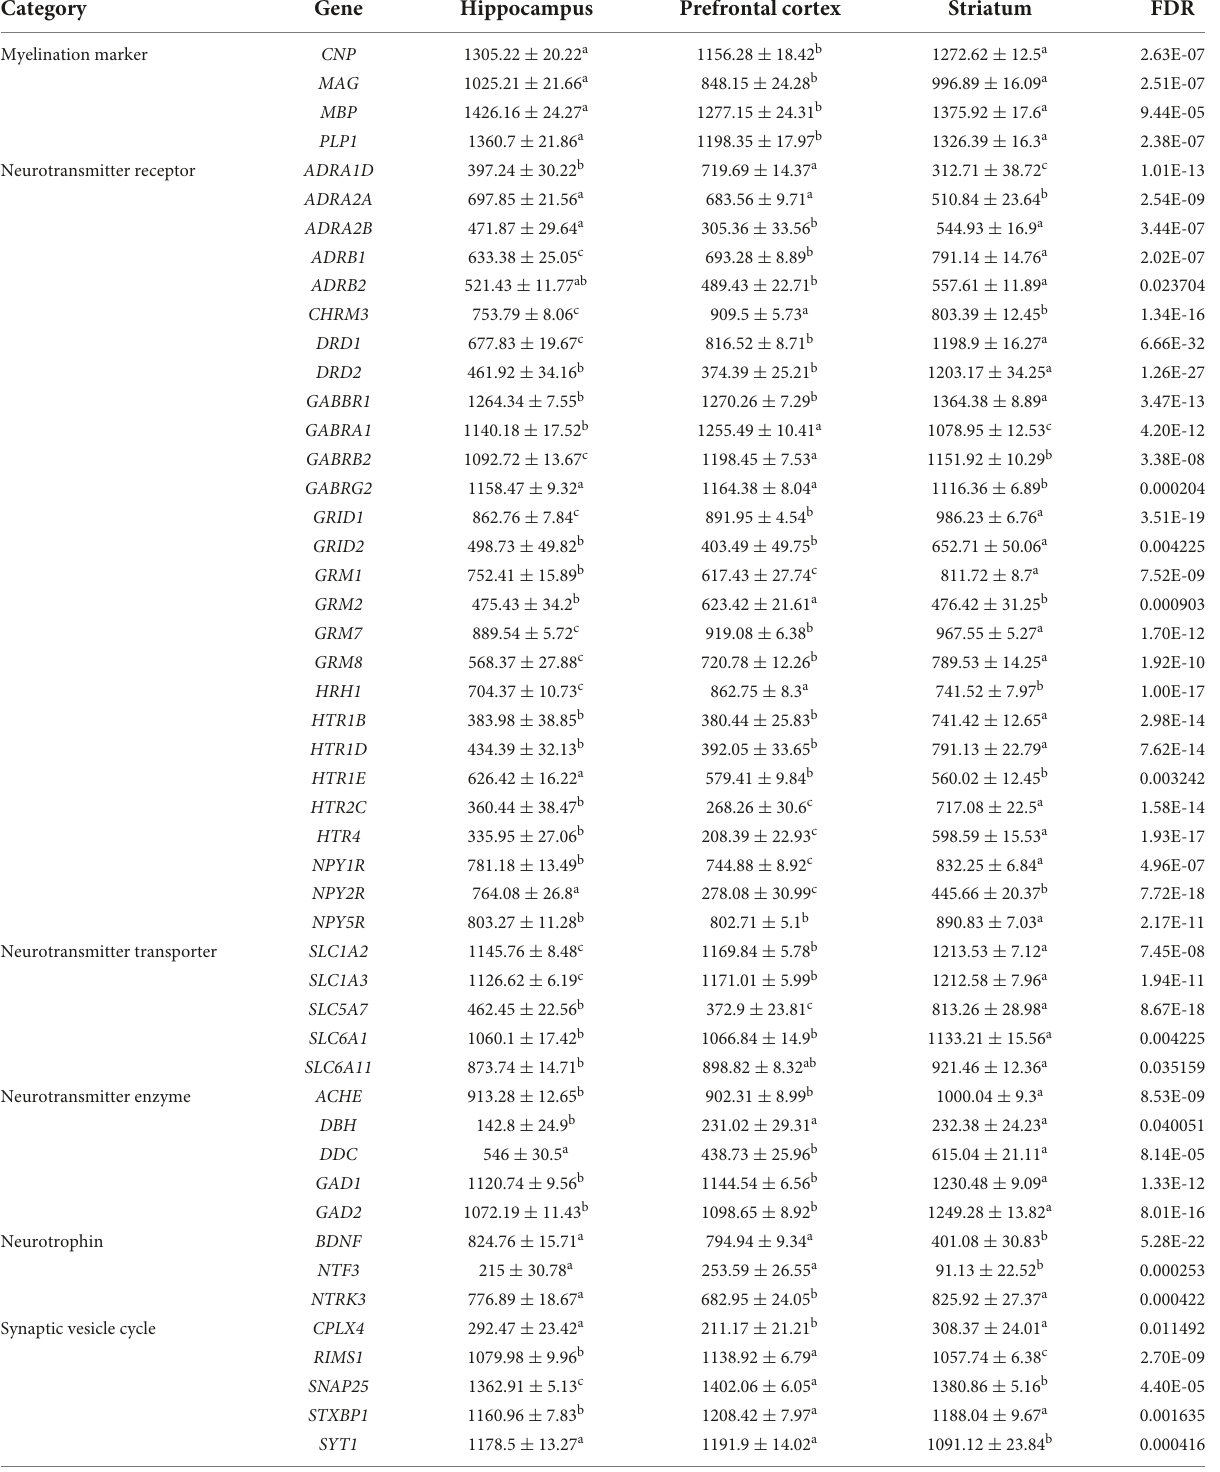
TABLE 3 Expression levels of genes in the hippocampus ( n = 22), prefrontal cortex ( n = 23), and striatum ( n = 23) tissue samples of pigs fed ovine, bovine, or caprine milk